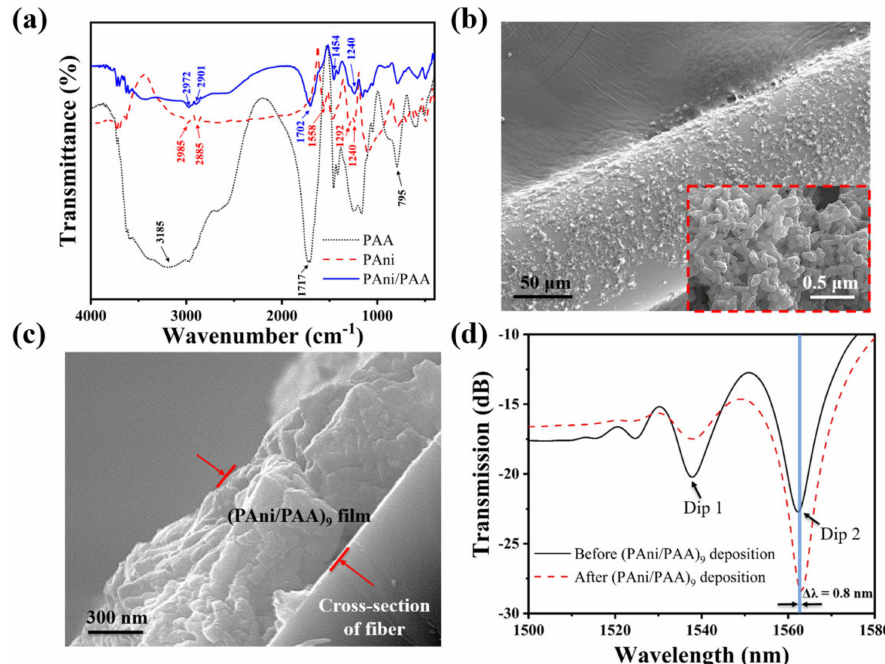
Figure 4. ( a ) FTIR spectra of PAni, PAA, and PAni/PAA; ( b ) SEM photos of the NCF with the PAni/PAA coatings; the inset is the scale–up image; ( c ) the cross–section of the NCF with the PAni/PAA coatings; ( d ) transmission spectrum of the SNS before and after the (PAni/PAA) 9